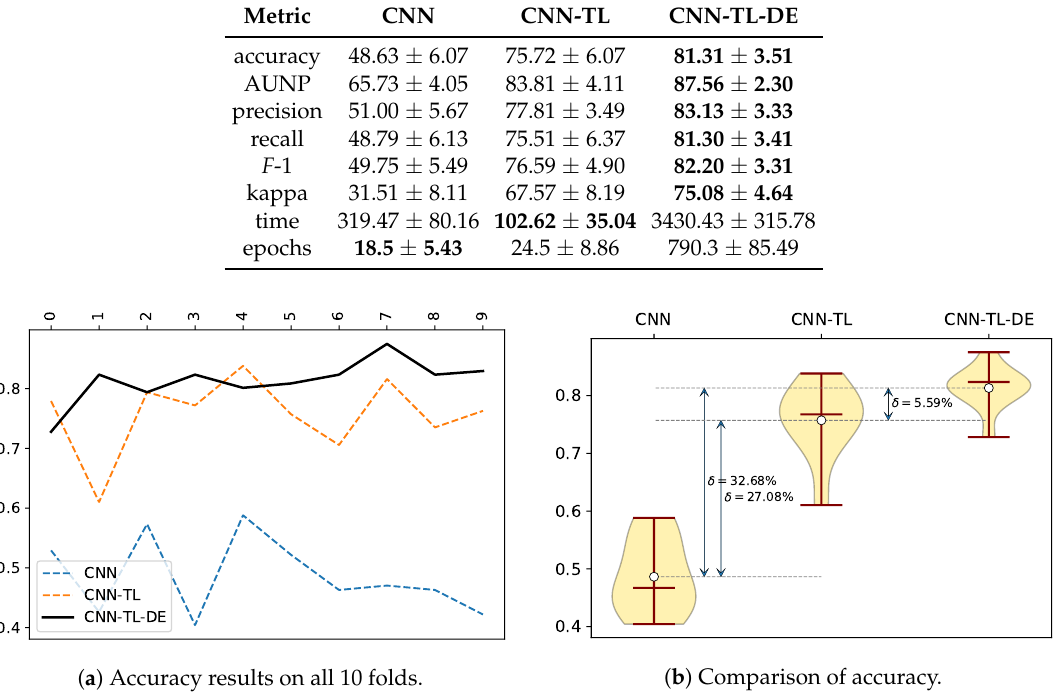
Figure 3. Comparison of accuracy results for the compared methods over 10